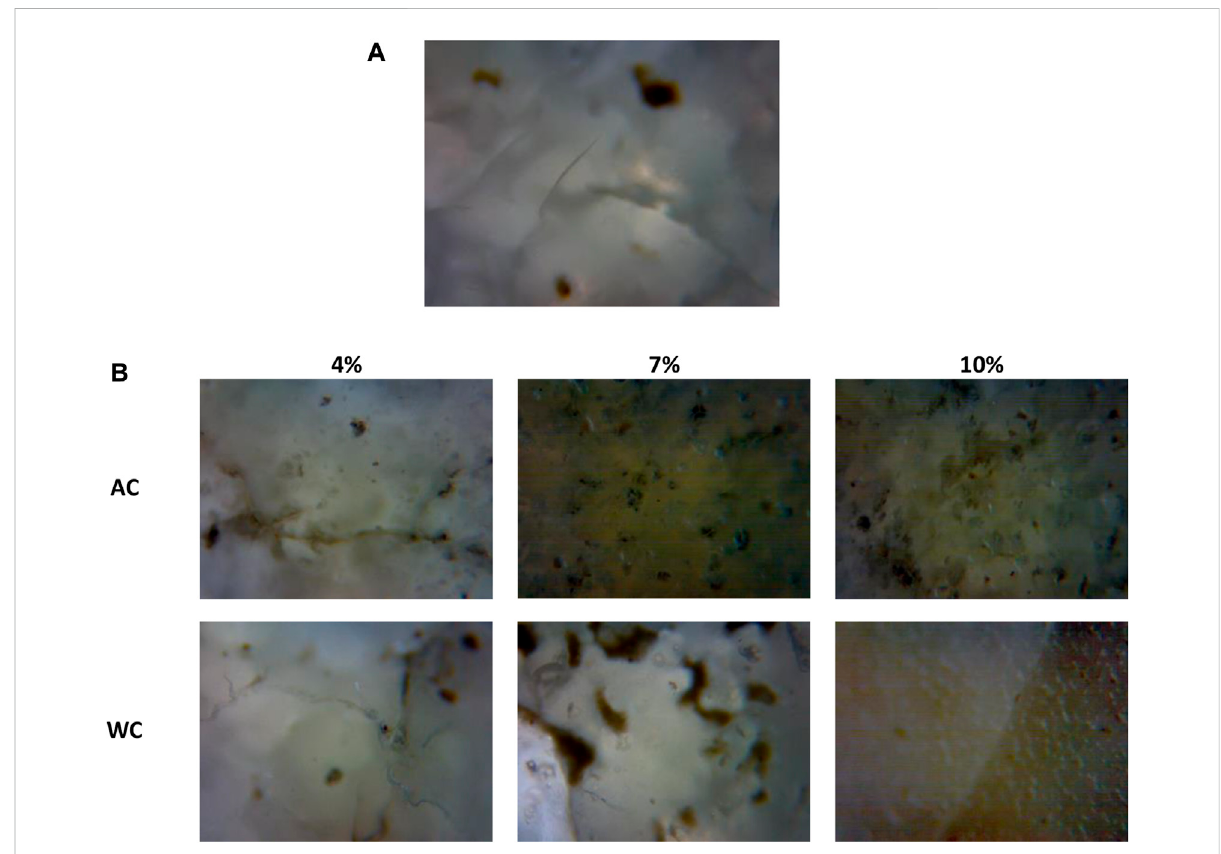
FIGURE 14 Optical images of: (A) PLA and (B) PLA composites loaded with AC and WC after 5 months of burial time with (100×) magni fi cation.